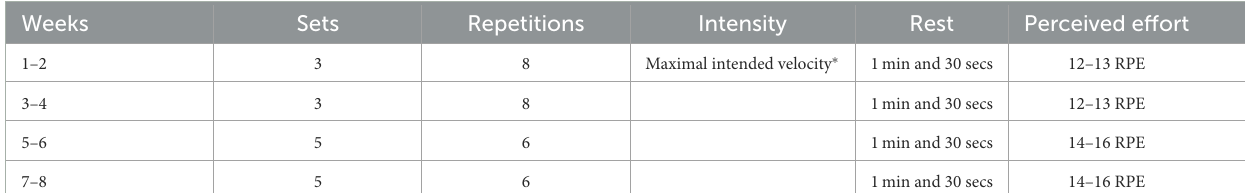
TABLE 3 Training progression during the program.